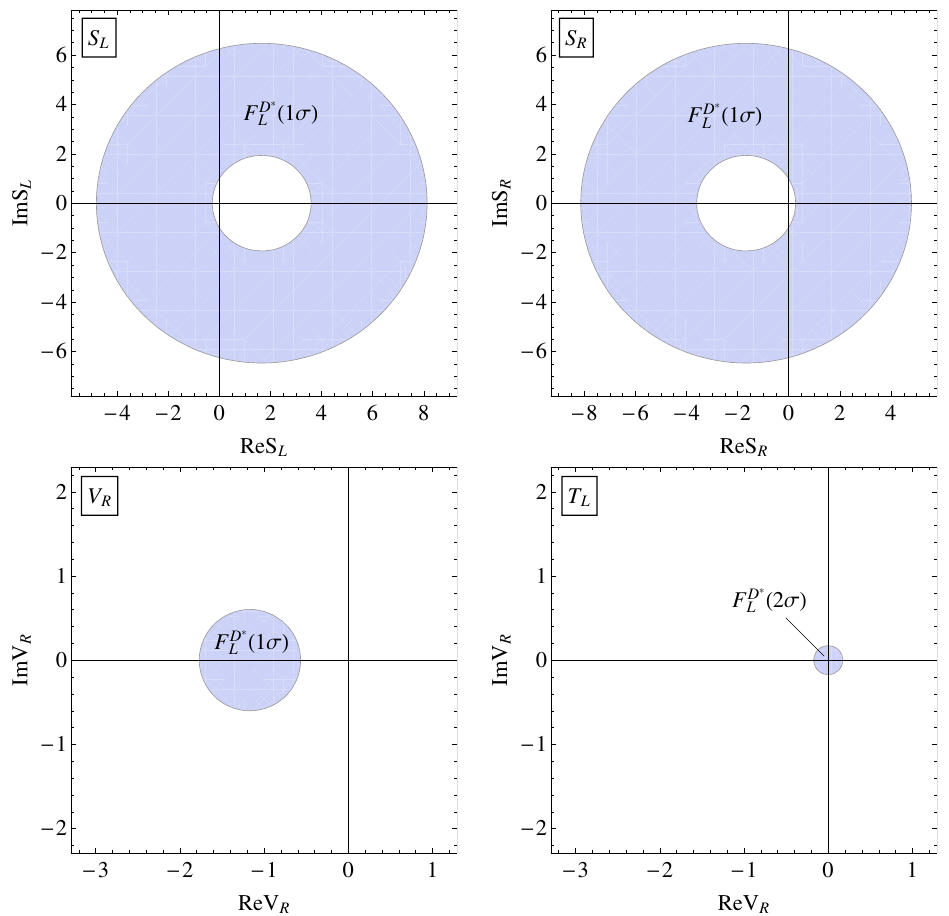
Figure 2. Constraints on the complex Wilson coefficients S L ( upper, left ), S R ( upper, right ), V R ( lower, left ), and T L ( lower, right ) from the measurement of F D ∗ 2 σ (for T L ). The allowed regions are indicated in gray color.